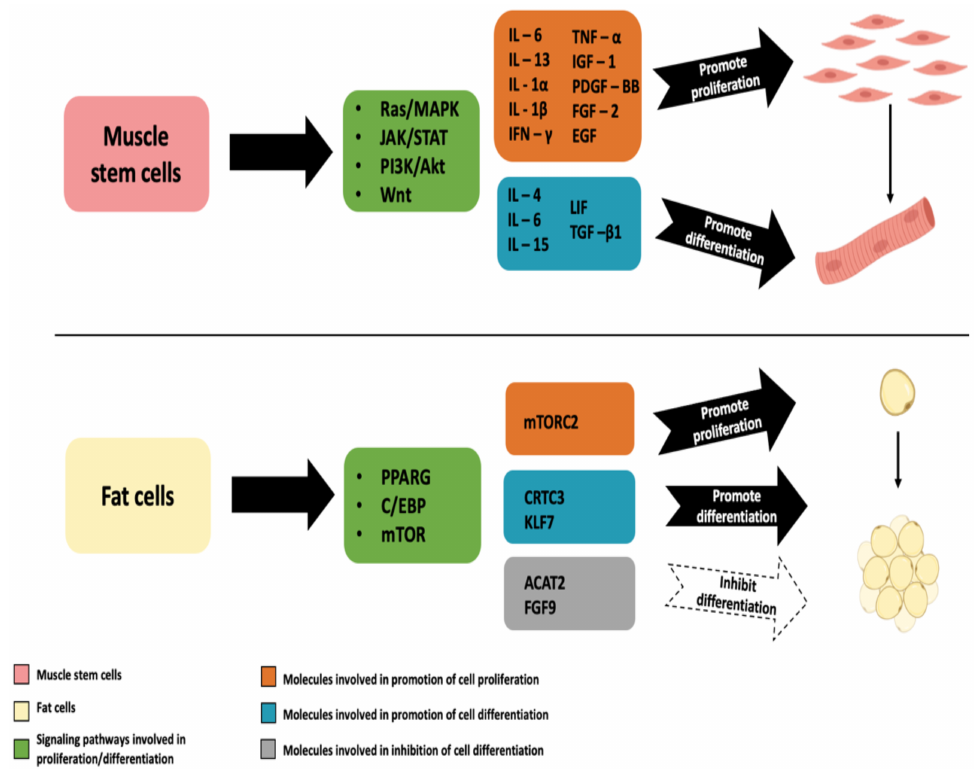
Figure 4. Signaling pathways involved in proliferation and differentiation of myogenic and adi- pogenic